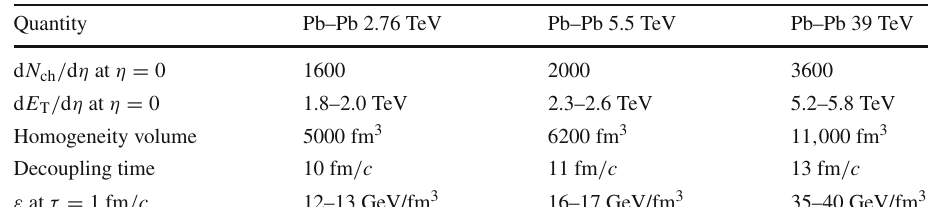
Fig. 16.1 Left: space-time profile at freeze-out from hydrodynamical calculations for central PbPb collisions at √ = 5 . 5 TeV and 39 TeV. s NN Right: time evolution of the QGP temperature as estimated on the basis of the Bjorken relation and the Stefan–Boltzmann equation (see text for